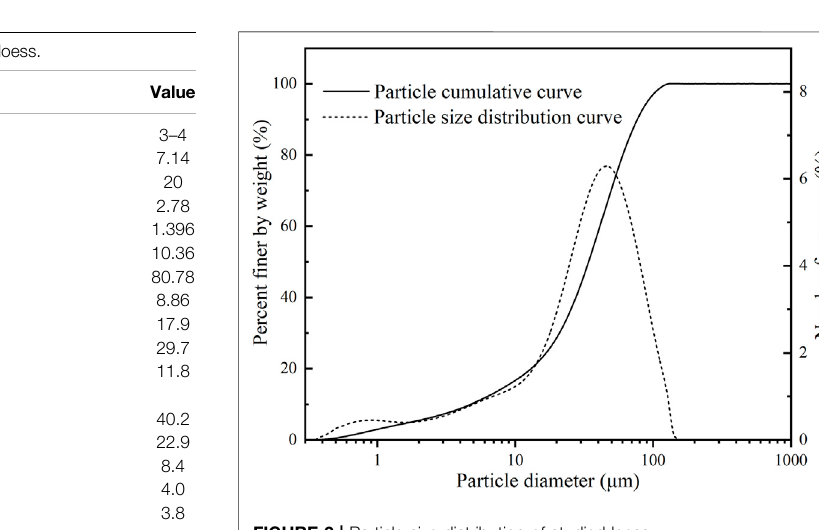
FIGURE 2 | Particle size distribution of studied